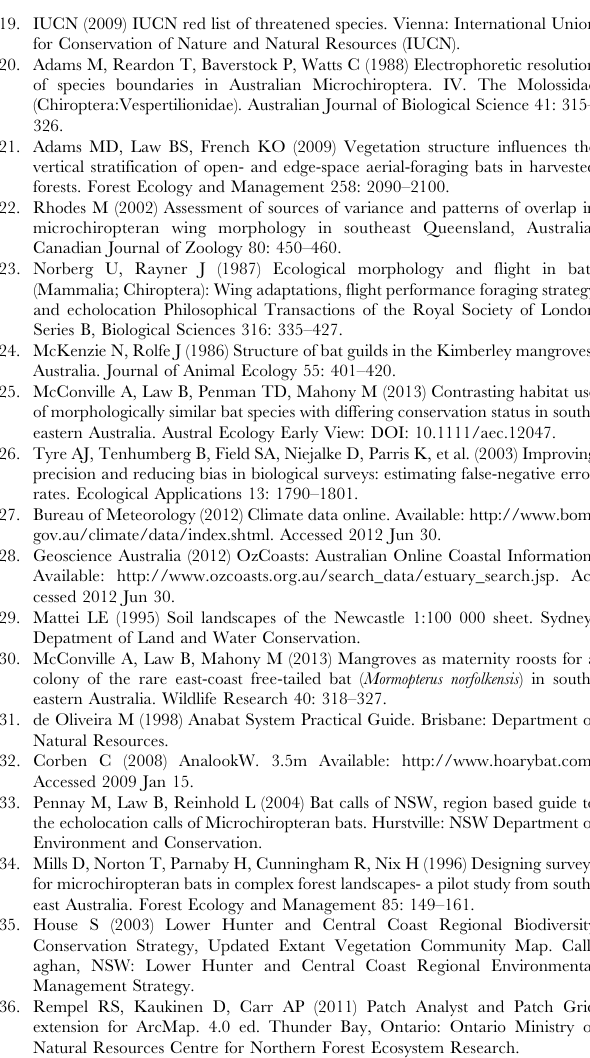
Figure S1 Sensitivity and probability of occurrence threshold. Effect of the probability of occurrence threshold on the sensitivity (dotted line), specificity (dashed line) and kappa (black line)